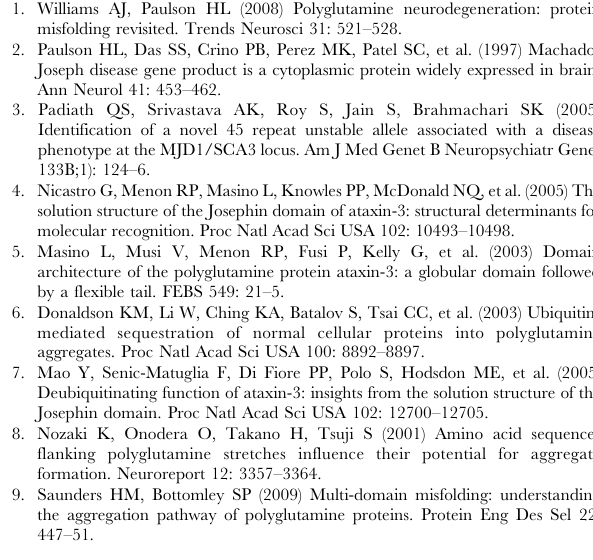
normalization at the tyrosine peak. (TIF) Figure S2 FTIR absorption spectra of freshly purified (blue profile) and mature pelleted aggregates (red profile) of AT3 variants. (TIF) Figure S3 FTIR spectra of AT3Q55 aggregates treated with SDS buffer. (TIF) Figure S4 Tapping mode AFM images (height data) of the truncated variant AT3/182 D . The protein was incubated at 37 u C for: (A) 0 h; (B) 24 h; (C) 72 h. Scan size 2 m m, Z range (A) 10 nm; (B) 20 nm; (C) 15 nm. (TIF) Figure S5 Tapping mode AFM images (height data) of the normal full length variant AT3Q24. The protein was incubated at 37 u C for: (A) 0 h; (B) 24 h; (C) 72 h. Scan size 2 m m, Z range 20 nm. (TIF) Figure S6 Tapping mode AFM image (left, height data; right, amplitude data) of the expanded variant AT3Q55. The protein was incubated at 37 u C for 48 h. Non fibrillar material completely covering a fibril bundle is apparent in the middle of the image. A portion of another bundle is on the left. This unstructured material can be removed by sample treatment with SDS, to reveal the fibril morphology (see Fig.6). Scan size 1.9 m m, Z range 200